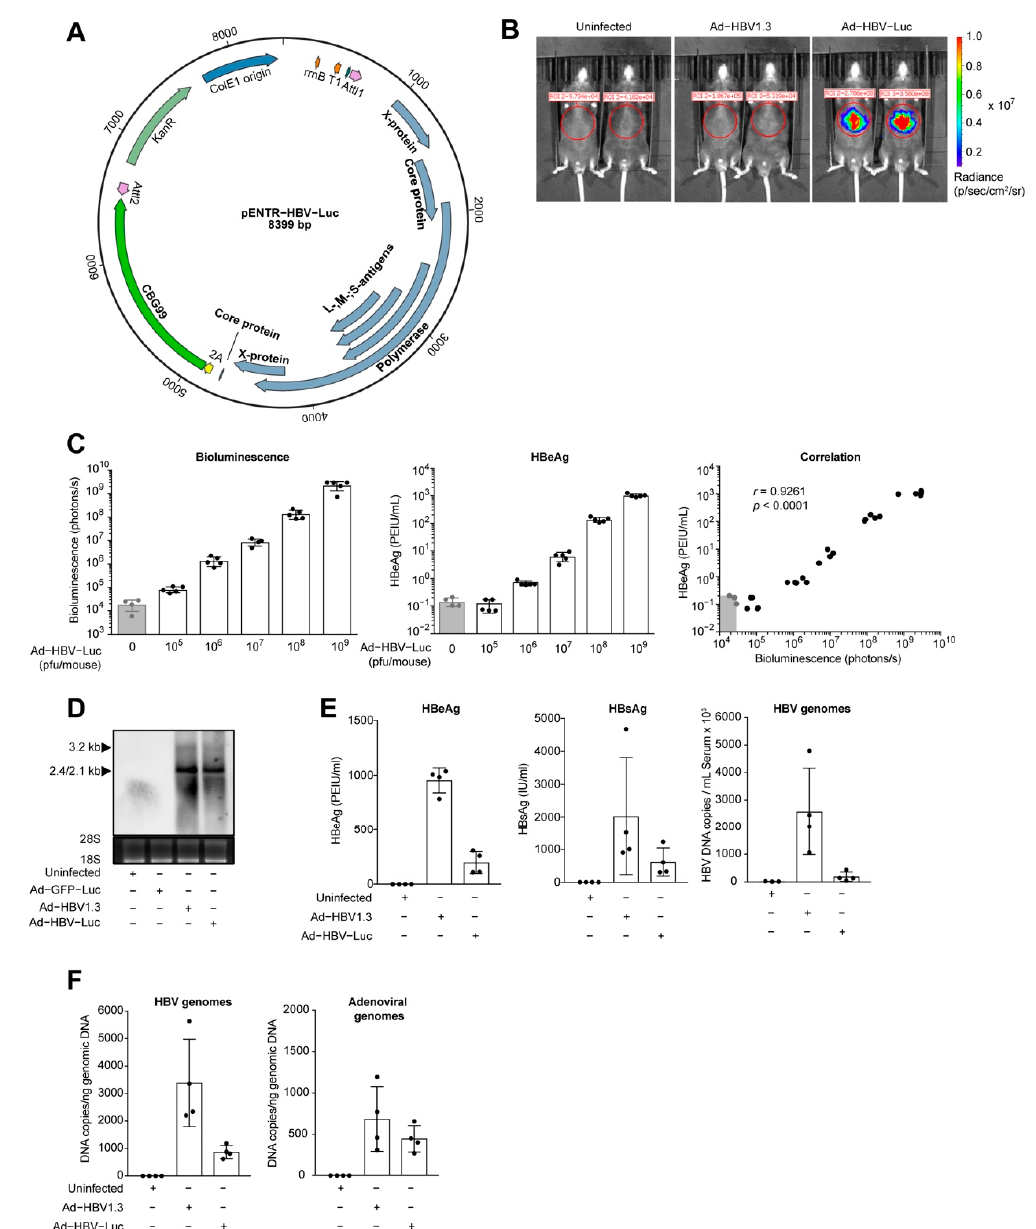
Figure 1. Transfer of HBV genomes in murine liver by adenoviral vectors. ( A ) Vector map of the pENTR plasmid with cloned HBV1.3 overlength genome, P2A site and CBG99 luciferase (pENTR-HBV-Luc). ( B ) Bioluminescence imaging of mice at day 8 post infection with Ad-HBV1.3 (5 × 10 8 pfu) or Ad-HBV-Luc (5 × 10 8 pfu). ( C ) Quantification of bioluminescence in the liver and serum HBeAg in mice infected 7 days with increasing doses of Ad-HBV-Luc (10 5 to 10 9 pfu). ( D ) Northern blot analysis of total liver RNA from mice infected 8 days with 5 × 10 8 pfu Ad-GFP-Luc, Ad-HBV1.3 or Ad-HBV-Luc. 28S and 18S ribosomal RNAs served as a loading control and were detected by exposure to ultraviolet light for 0.6 s. HBV-specific fragments with 3.2 kB (pgRNA) and 2.4/2.1kb (preS/S RNA) length were detected using an